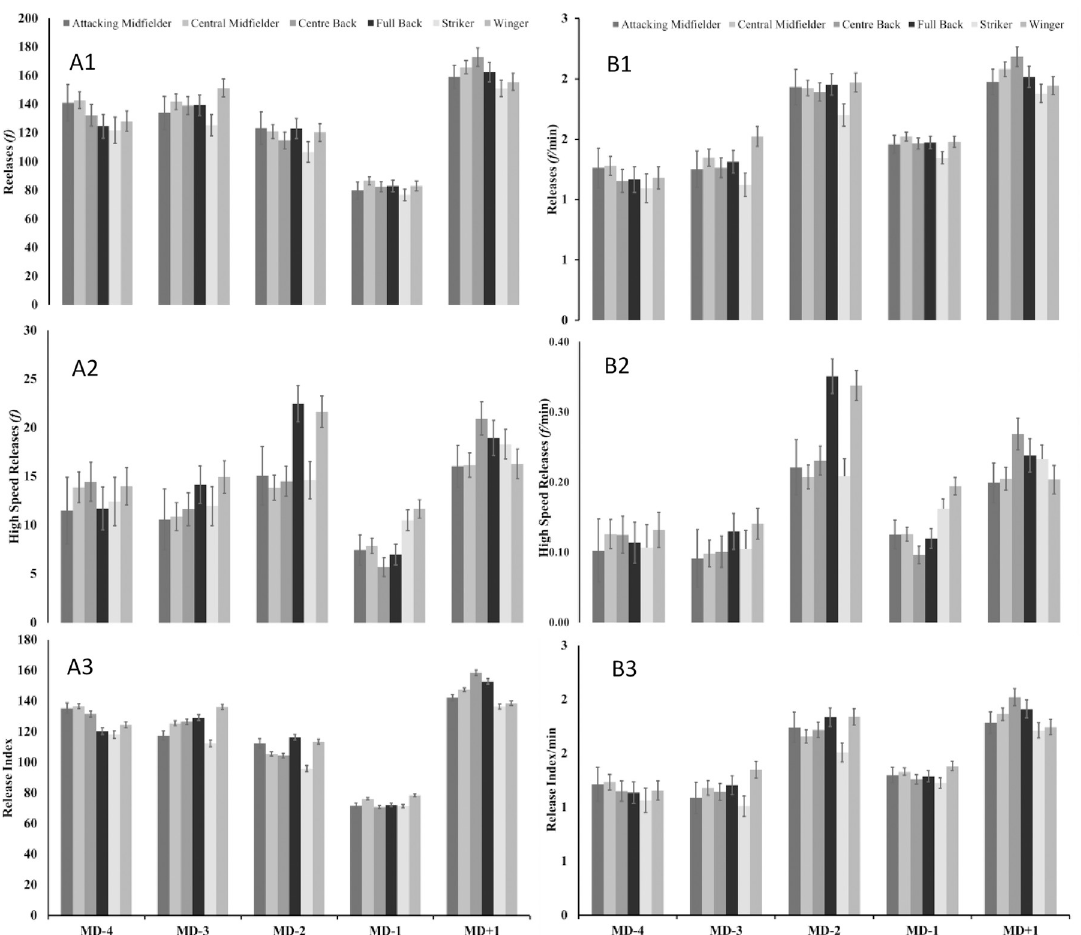
Fig 1. Absolute (A) and relative (B) estimated marginal means for number of ball releases (1), number of high-speed ball releases (2) and ball release index (3) during different training days according to match proximity (match day